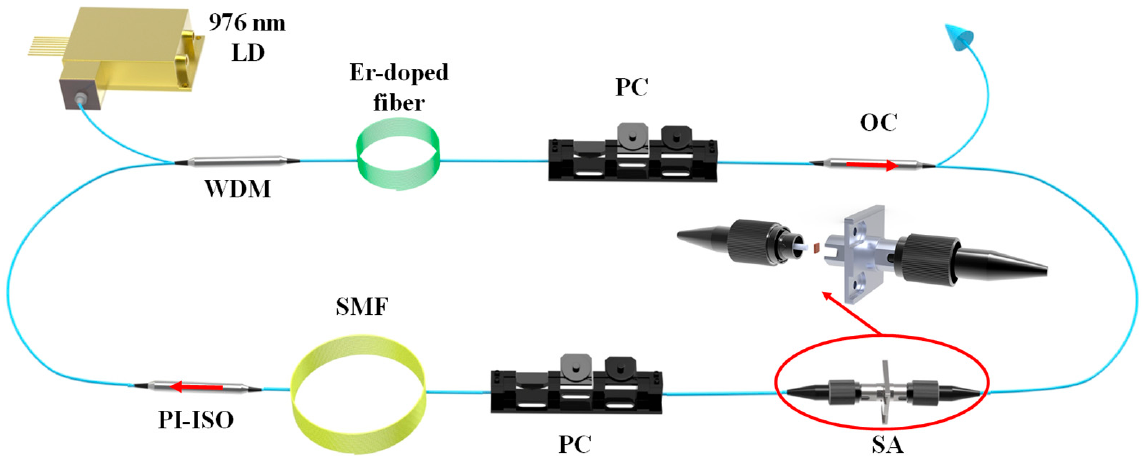
Figure 4. Structure of the low-threshold mode-locked fiber laser.